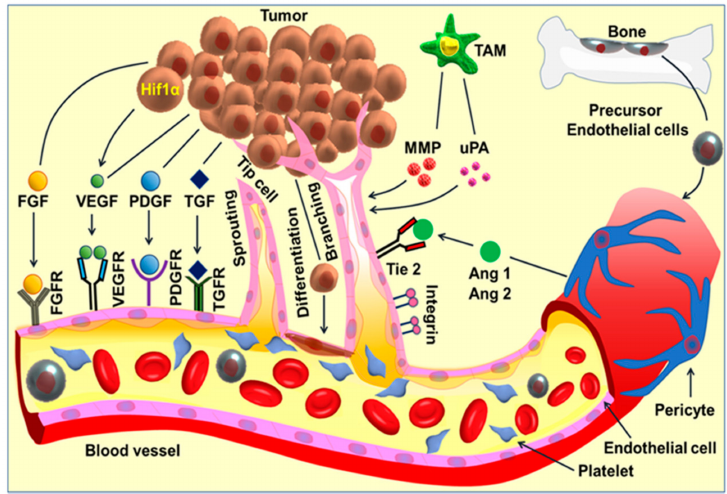
Figure 1. Angiogenic signaling pathway and angiogenesis. Tumor cell induces a complex cascade of angiogenic signaling and activates downstream cellular events in multiple cell types, especially the endothelial cells, leading to angiogenesis. Pro-angiogenic factors include fibroblast growth factor (FGF) families, vascular endothelial growth factor (VEGF), platelet-derived growth factor (PDGF), transforming growth factors-alpha / beta (TGF- α / β ), and angiopoietin (Ang 1,2) and the associated receptors. The detachment of the perivascular cells from the mature blood vessels initiates vessel remodeling and endothelial cell proliferation. Platelets become activated and recruited to the sites of the exposed basement membrane. Tumor-associated macrophages (TAM) produce angiogenic factors such as VEGF, MMPs and urokinase-type plasminogen activator (uPA). On the other hand, precursor endothelial cells move to the perceived wound site and release angiogenic factors. The activated endothelial cells release proteases and lead to extracellular matrix (ECM) remodeling, followed by directional sprouting. The signaling cascades activate tube formation and branching, followed by vessel arterio-venous patterning and maturation. Cancer progenitor / stem cells can di ff erentiate to endothelial cells, and thereby participates directly in